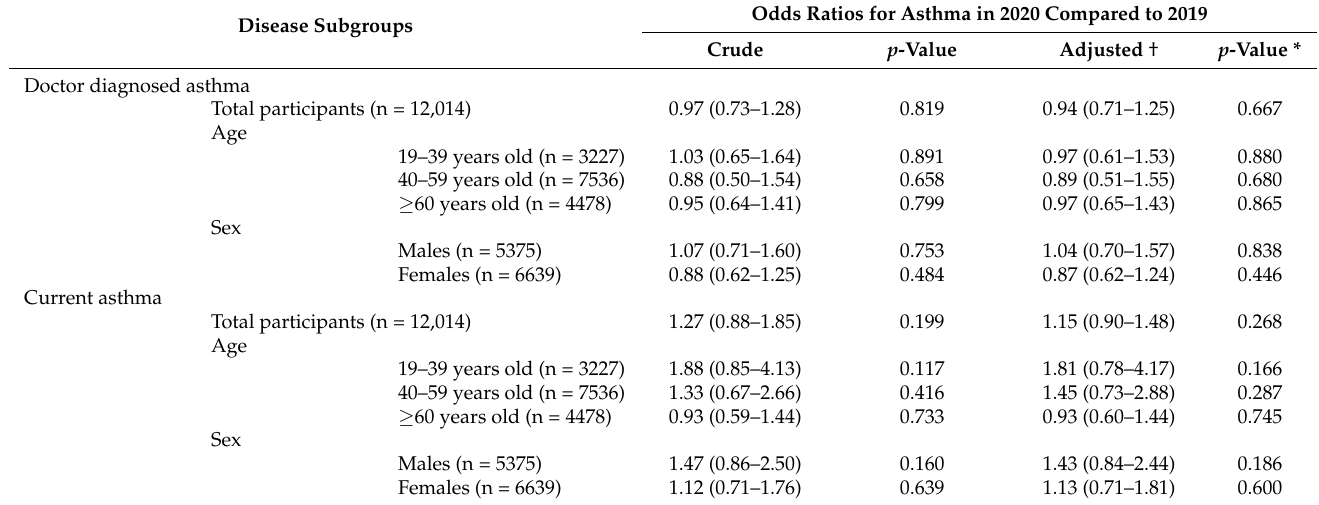
Table 2. Odds ratios (95% confidence intervals) for asthma (doctor diagnosed asthma, current asthma) in 2020 compared to 2019 with subgroup analyses according to age and sex.